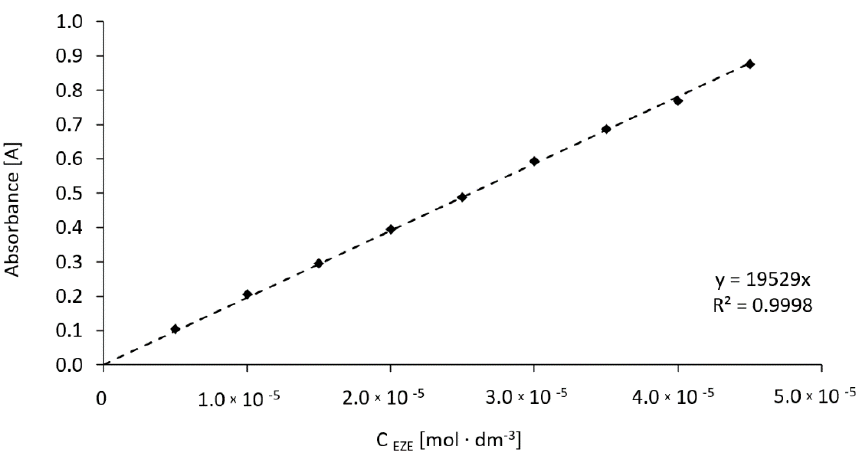
Figure 16. Calibration curve of ezetimibe for λ = 232 nm.